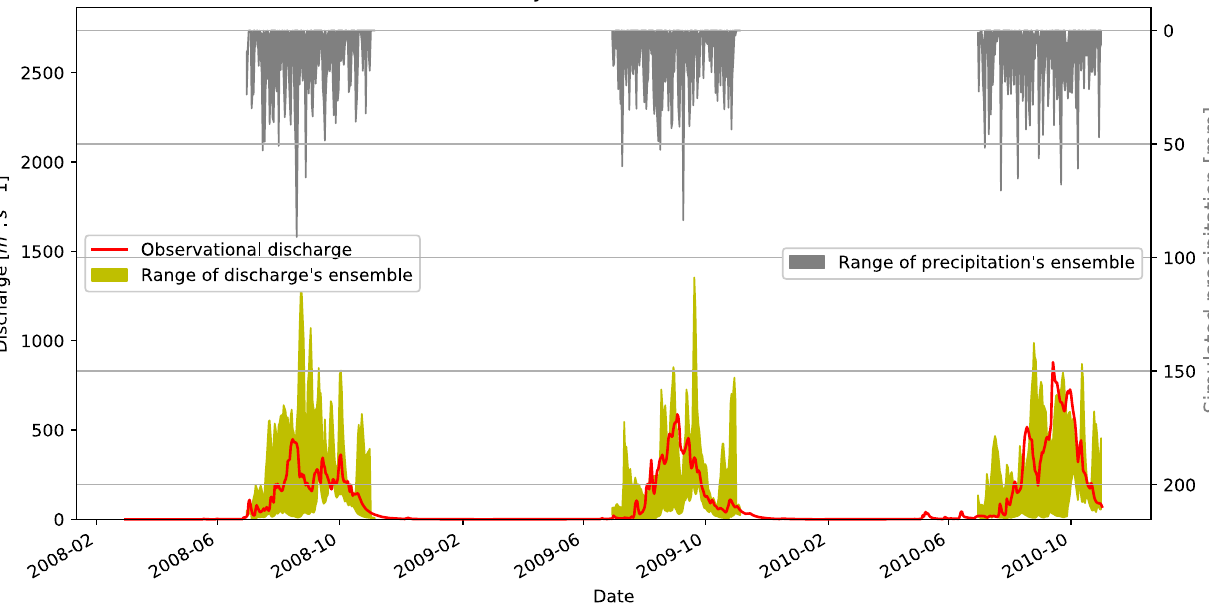
Figure 14. Ensemble (WRF-Hydro-SKEBS) of simulated hydrographs and precipitations at Savè and Bétérou.